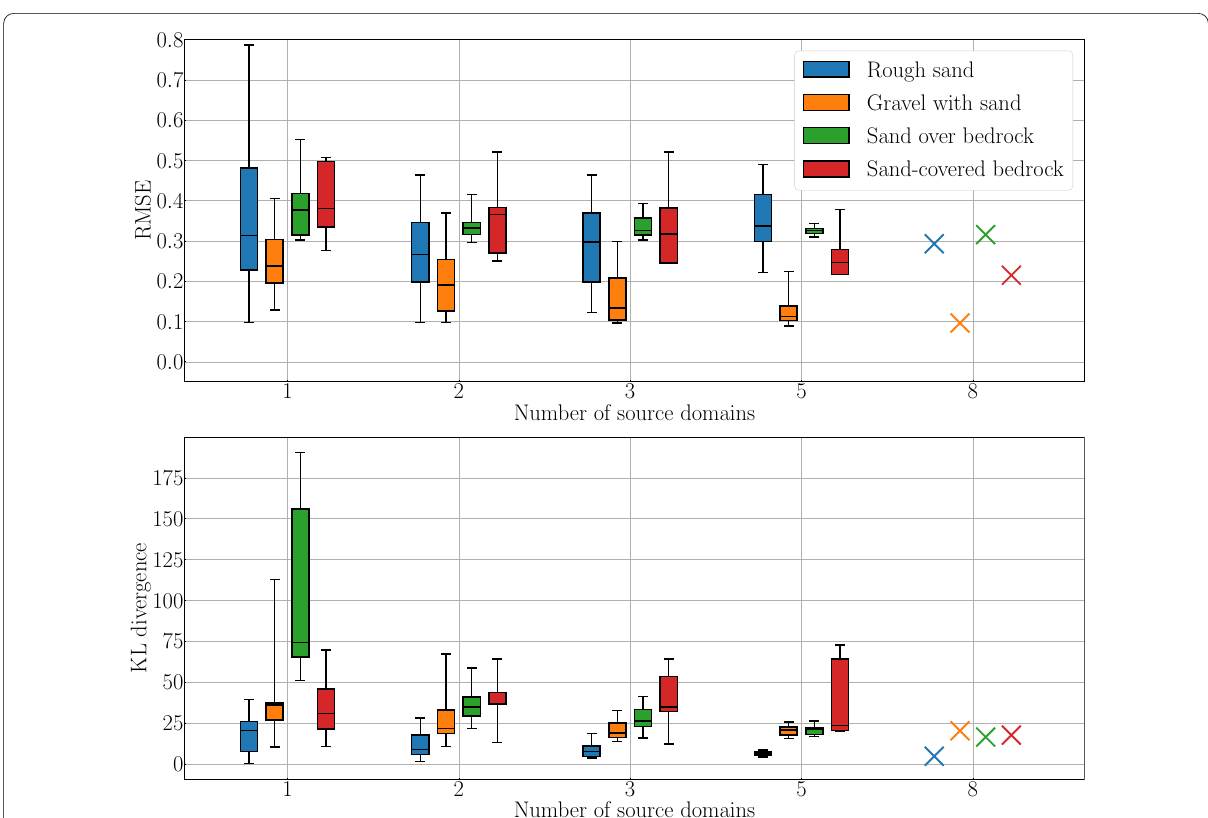
Fig. 9 Results of Evaluation 2. Stats of the RMSE and KLD are plotted for the models learned with various numbers of source domains for the four target domains. The result with eight source domains is represented by the cross. The variability in RMSE and KLD decreases along with the increase in the number of source